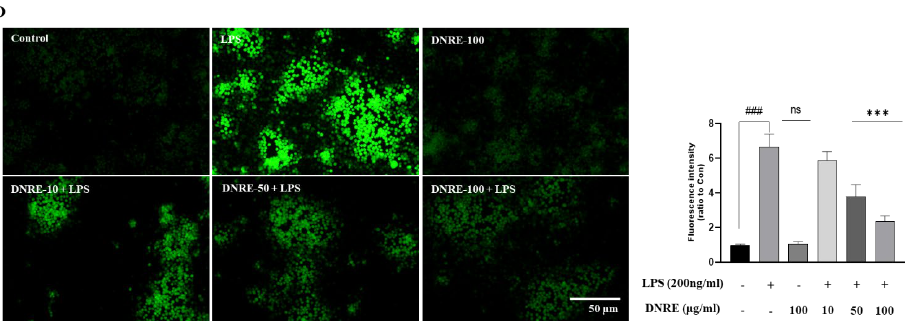
Figure 1. DNRE treatment protects microglial cells. ( A ) MTT assay (IC 50 = 152.2997 µ g/mL) and ( B ) nitric oxide release assay for LPS-treated BV-2 cells with or without different doses of DNRE. ( C ) Sigmoid plot for determination of IC 50 value of DNRE of DPPH free radical scavenging. The half maximal inhibitory concentration (IC 50 ) was calculated from the equation (y = mx-c) obtained from the sigmoid curve. The value of ‘y’ was changed to 50, and we were subjected to determine value of ‘x’, which is the IC 50 value. ( D ) Fluorescence microscopy of DCFDA assay for LPS-treated BV-2 cells with or without DNRE, and measurement of fluorescence intensity using ImageJ software. ns—not significant compared with non-treated; each shape (circles, triangles, squares, etc.) is repre- sentative of the number of repetitions of a particular group; ### p < 0.001 compared with non-treated; ** p < 0.01, *** p < 0.001 comparing LPS vs. LPS + DNRE; $$$ p < 0.001 comparing low-dose DNRE (10–20 µ g/mL) vs. mid-to-high-dose DNRE (50–400 µ g/mL), @@@ p < 0.001 comparing mid-dose DNRE (50–100 µ g/mL) vs. high-dose DNRE (200–400 µ g/mL).